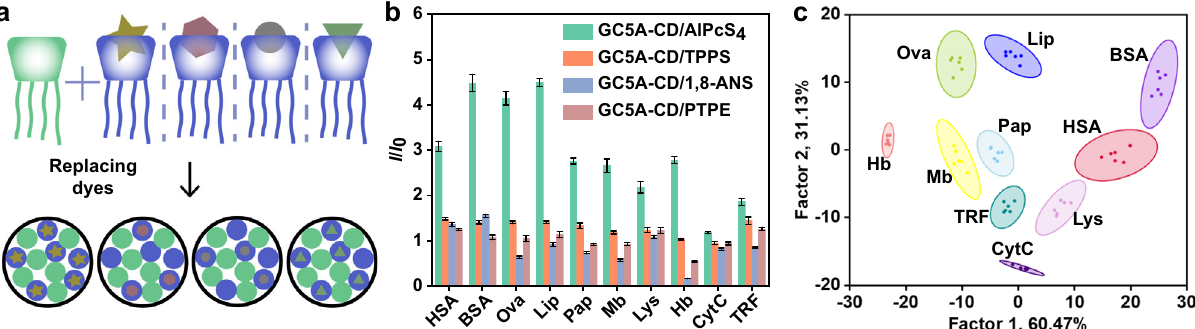
Fig. 4 Construction and experimental results of sensor array based on dye replacement. a Schematic diagram of SA3 . Pattern recognition of proteins using SA3 ([GC5A] = [CD] = 1.0 μ M, [dye] = 1.0 μ M). b Fluorescence response patterns of SA3 against various proteins (23.8 μ g/mL for each protein). The order of colored symbols from top to bottom in the legend corresponds to the column order of histogram from left to right. c Canonical score plot for the two factors of simpli fi ed fl uorescence response patterns obtained from LDA with 95% con fi dence ellipses. Error bars in b represent mean ± s.d. ( n = 6